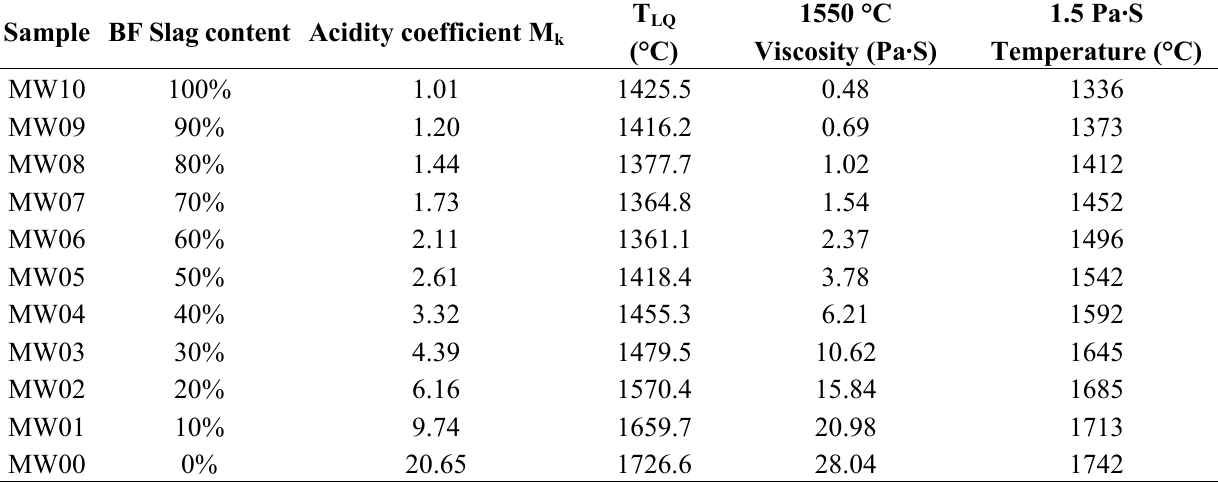
Table 2. The liquid temperatures and viscosities of mixtures.